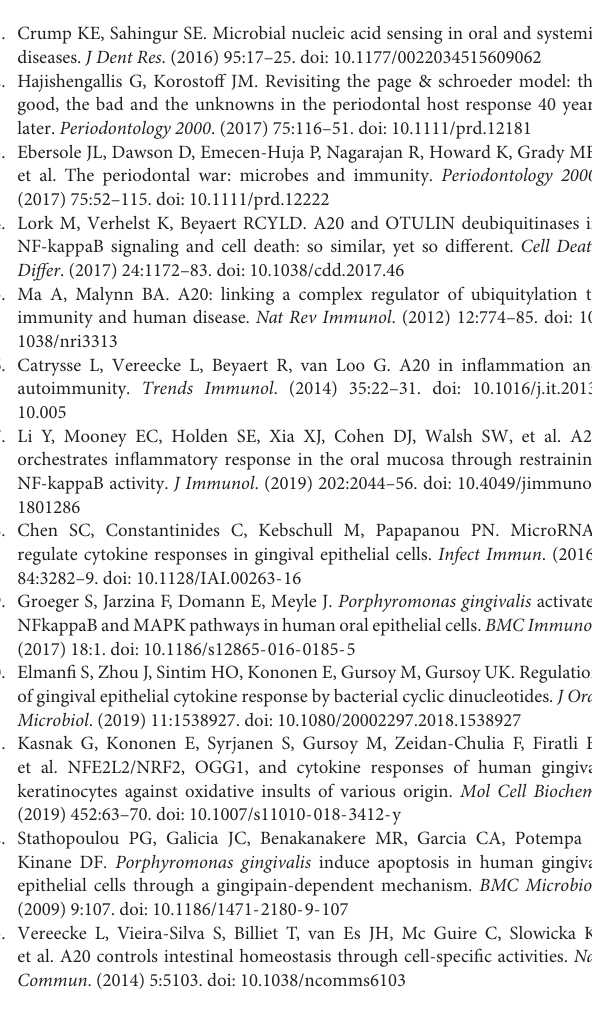
FIGURE S1 | A20 restricts apoptosis in gingival keratinocytes induced by CPT treatment. ELISA detecting cytoplasmic histone associated DNA fragments in TIGKs with altered A20 expression or control cells with CPT treatment. A20 depleted and control cells (A) , or A20 over-expressing cells and control cells (B) were treated with 1 uM CPT for 6 h and applied to Cell Death Detection ELISA. Each experiment was performed three times independently and the representative experiments were plotted with mean and standard errors. # Unstimulated cells versus corresponding CPT treated cells ( ## P ≤ 0.01, ### P ≤ 0.001,